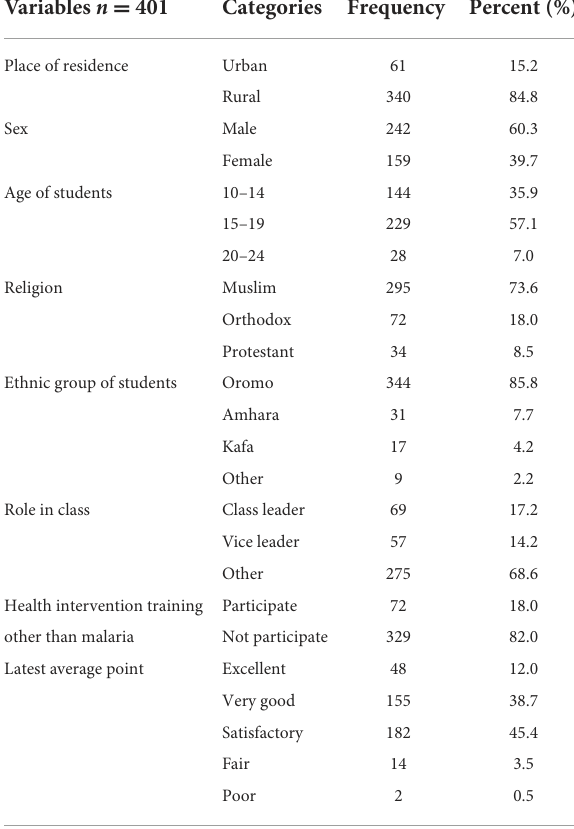
TABLE 1 Socio demographic characteristics of the participants, Jimma zone, south west Ethiopia,